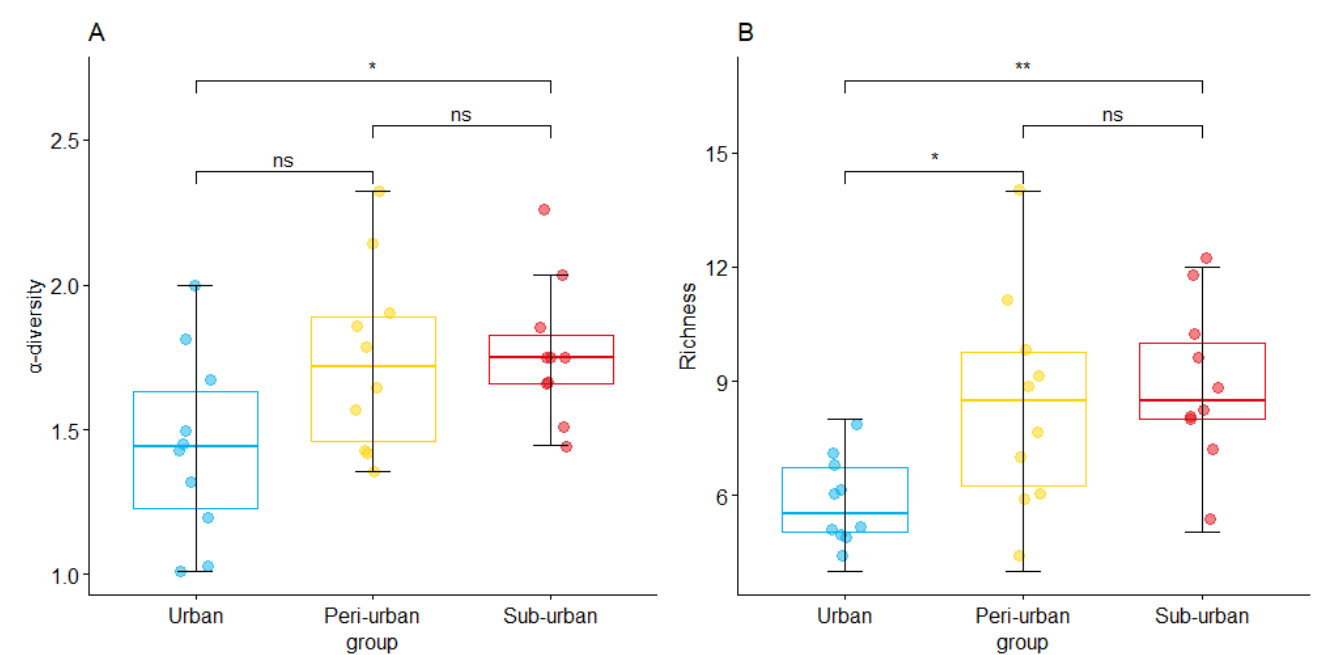
Figure 5. Upper-stratum guild α -diversity ( A ) and richness ( B ) under different urbanization types of mountain parks. Boxplots show the range of data about the median, with open circles representing outliers and filled circles representing the mean. Stars indicate significance levels (ns = not significant; * = p < 0.05; ** = p < 0.01).